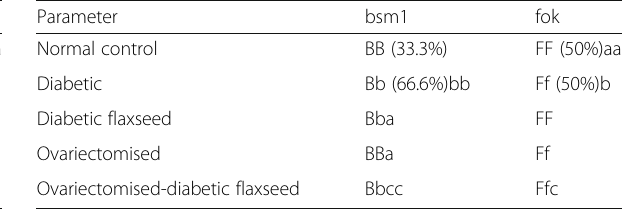
Table 4 Comparison of vitamine D receptor genes between